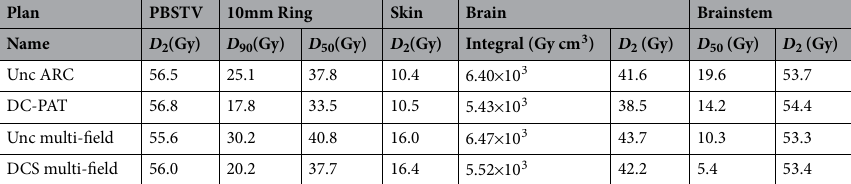
Table 2. Dose-volume histogram results of the treatment planning studies by delivery technique.